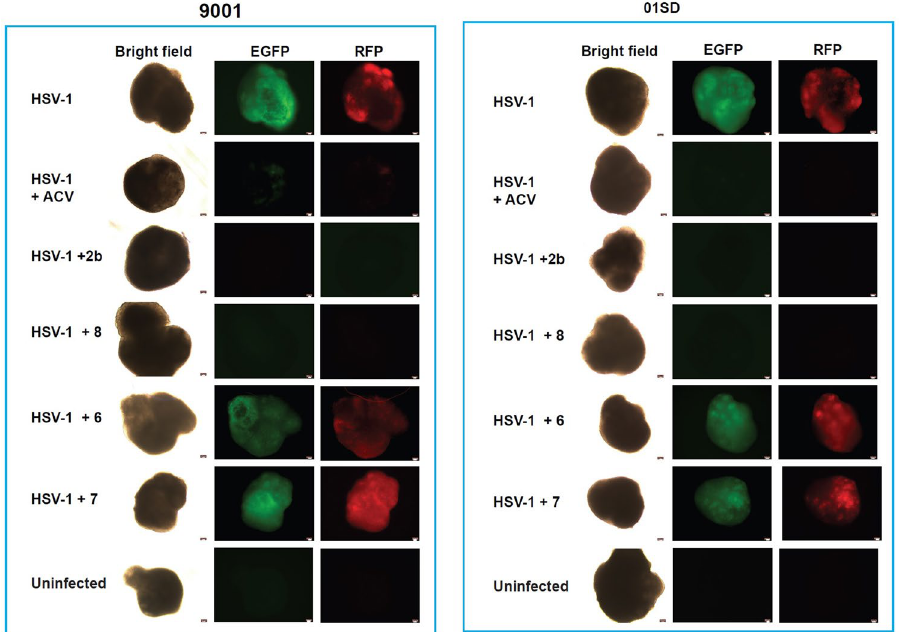
Figure 5. The anti-HSV-1 efficacy of compound 8 is comparable to 2b and ACV, in human brain organoids. Fourteen-week old brain organoids generated from 9001 and 01SD iPSC-lines were infected individually with HSV-1 DualF construct (6000 pfu/organoid). Two hours after infection inocula were removed, organoids washed and cultured in the presence of the tested compounds. The expression of the fluorescent reported genes EGFP and RFP was visually inspected under a fluorescent microscope at day 3 p.i. N = 3 for each condition. Scale bar: 50